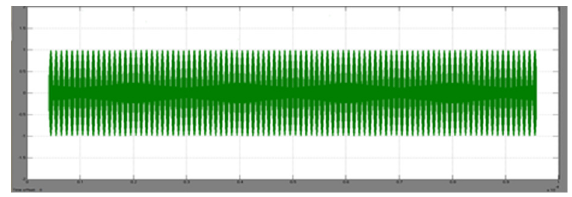
Fig. 14. Even and Odd Pulses.